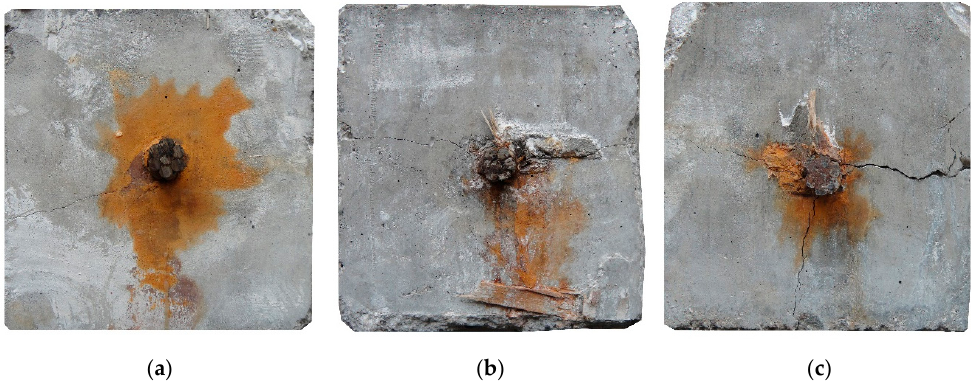
Figure 5. Radial cracks at beam end: ( a ) One crack; ( b ) two cracks; and ( c ) three cracks.